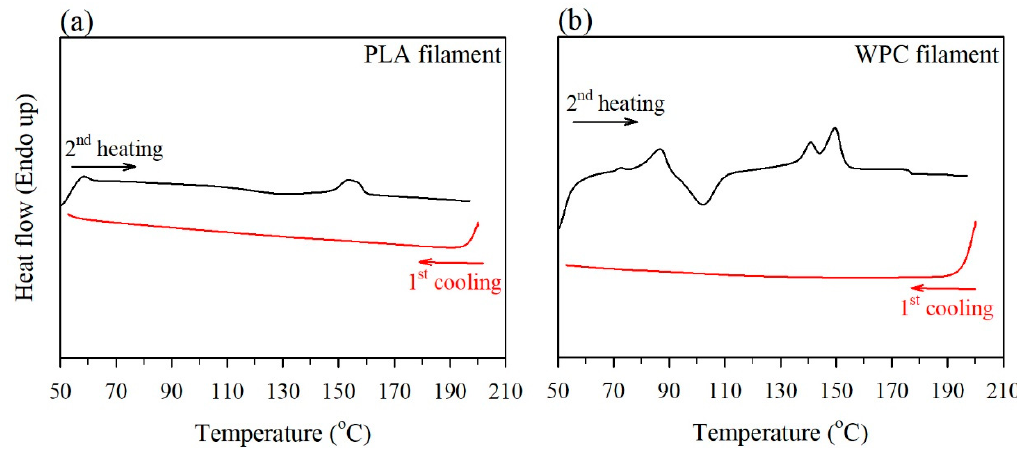
Figure 5. DSC thermograms of the PLA filament ( a ) and WPC filament ( b ) at the the first cooling process (10 °C/min) and the subseguent second heating process (10 °C/min).